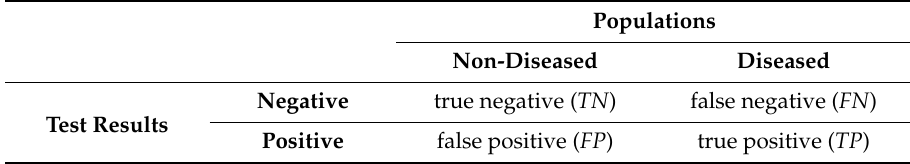
Table 1. A 2 × 2 contingency